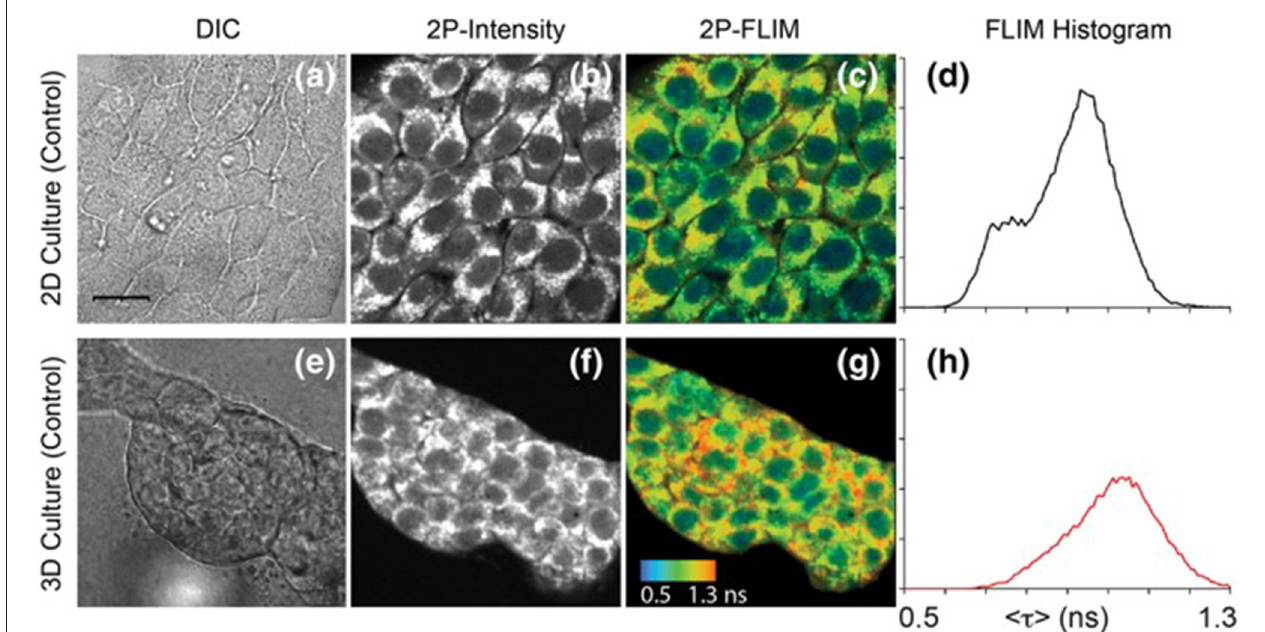
FIGURE 4 | Images of NAD(P)H in 4T1 cells taken from a 2D monolayer culture and 3D matrix culture showing differential interference contrast microscopy (a,e) , two-photon fluorescence intensity (b,f) , and two-photon FLIM (c,g) along with histograms of the fluorescence lifetimes from the FLIM images (d,h) . These images highlight the usefulness of two-photon excitation to image live cells in vivo as there were differences in cell metabolism, as indicated by NAD(P)H fluorescence, between cells cultured in a typical lab environment (2D monolayer) and those cultured in a more realistic environment (3D culture). Adapted with permission from